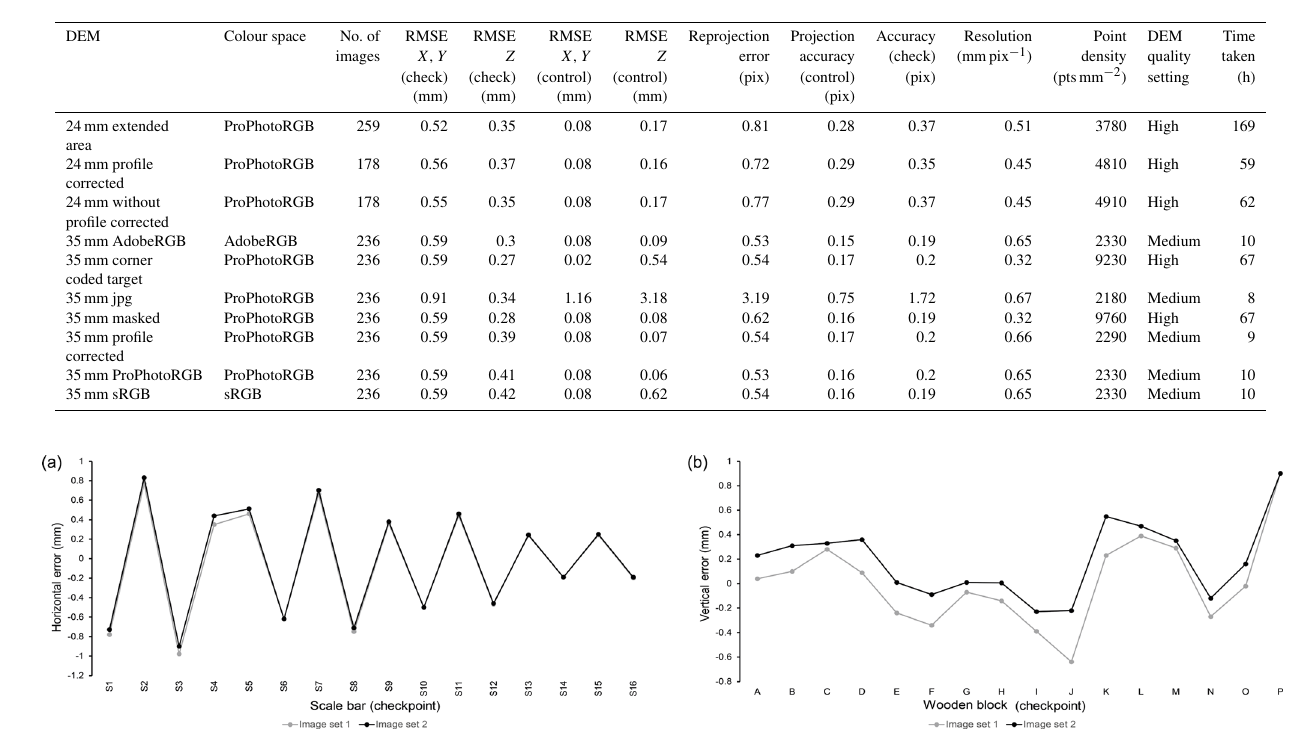
Table 4. Summary experimental DEM data. Reprojection error is the root mean square reprojection error (RMSE) averaged over all tie points on all images. In some publications, reprojection error is also referred to as RMS image residual (James et al., 2017a). In the Agisoft manual, reprojection error is defined as the distance between the point on the image at which a reconstructed 3-D point can be projected and the original projection of that 3-D point detected on the photo (Agisoft, 2016). It is used to quantify how closely an estimate of a 3-D point recreates the point’s original projection and as a basis for the 3-D point reconstruction procedure. Root mean square error (RMSE) XY is the root mean square error for X and Y coordinates for the control location or checkpoint. Root mean square error (RMSE) Z is the root mean square error for X and Y coordinates for the control location or checkpoint. Projection accuracy (in pixels) is the root mean square error for X , Y coordinates on an image for the control location or checkpoint averaged over all the images.